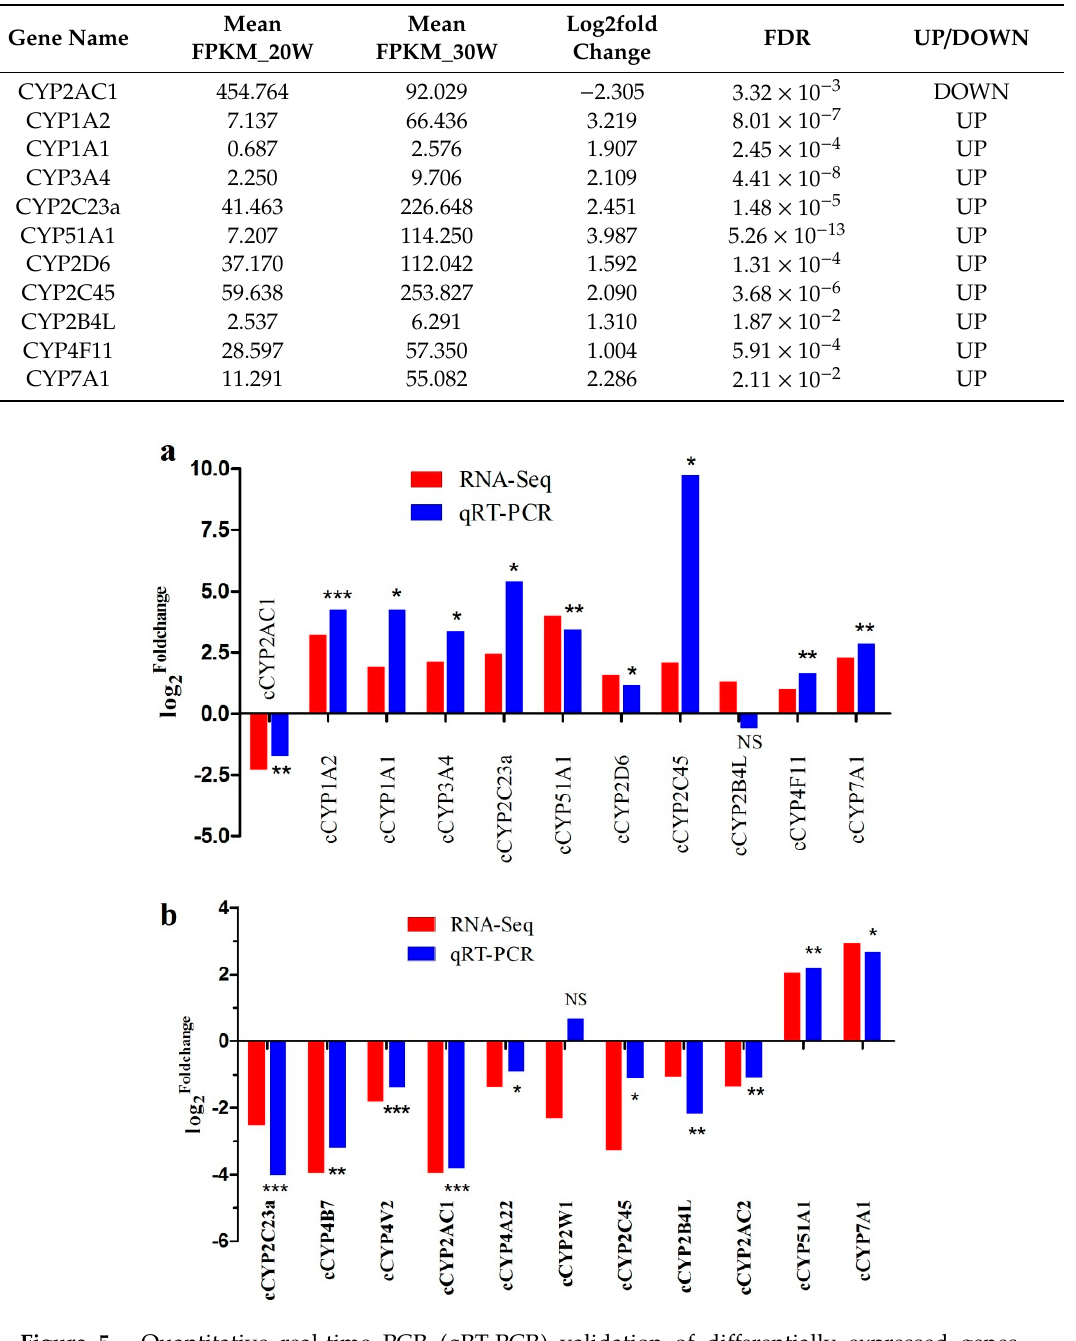
Figure 5. Quantitative real-time PCR (qRT-PCR) validation of differentially expressed genes. The relative expression values were calculated using the 2 − △△ CT method. Red indicates the log 2fold change of RNA-sequencing (RNA-seq) and green indicates the log 2fold change of qRT-PCR. Asterisks denote statistically significant differences of qRT-PCR ( t -test; * p < 0.05; ** p < 0.01; *** p < 0.001; NS p >